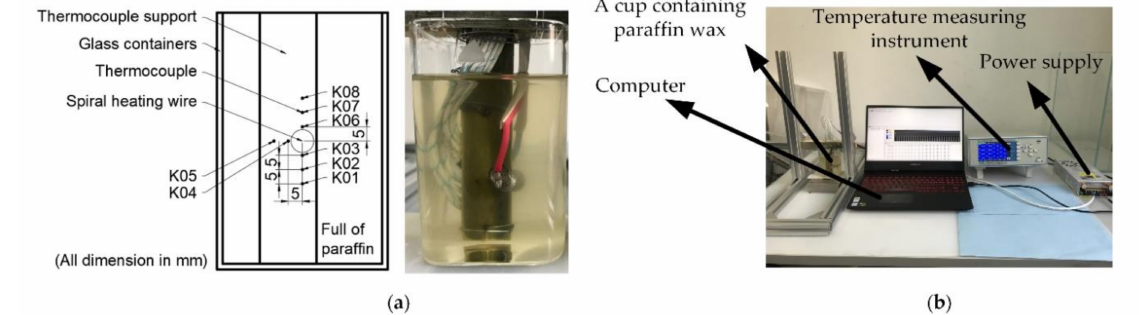
Figure 6. Design of heating device for para ffi n: ( a ) heating wire and supporting structure and insulation structure of heating wire; ( b ) the layout of the heating device in the buoyancy adjustment module and the leakage proof structure of the